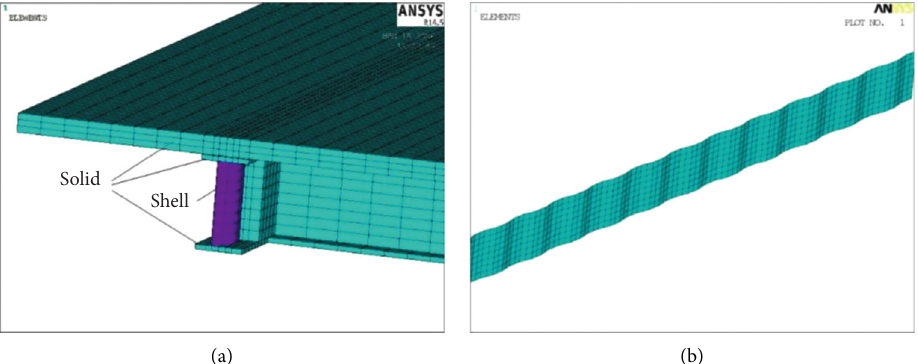
Figure 10: FE model of the two I-shaped GFRP with corrugated webs-concrete hybrid girder. (a) 3D finite element model. (b) Corrugated web.